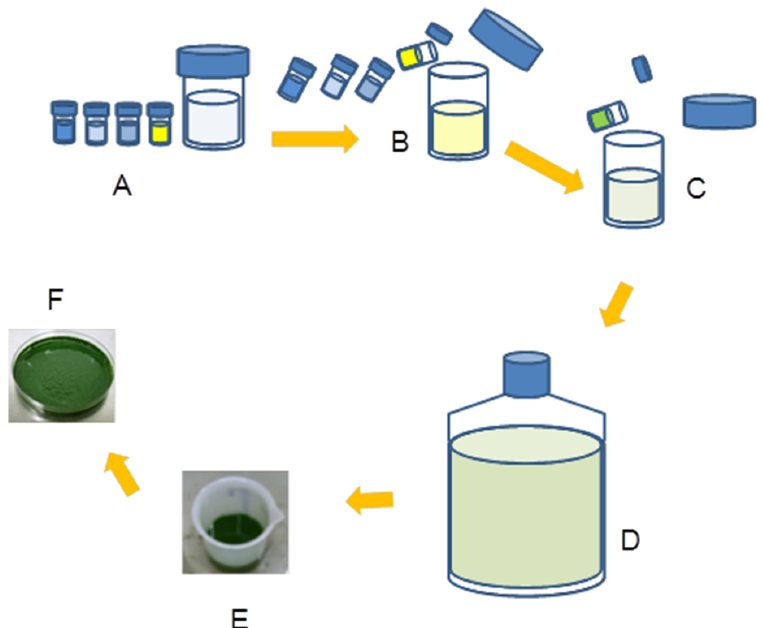
Figure 1. Cultivation of Egyptian A. platensis strain in the laboratory under static conditions. ( A ) Preparation of membrane filter 1.5 × medium components from parts A–C and the autoclaved part D; ( B ) mixing of the medium components under aseptic conditions; ( C ) adding the seed culture of A. platensis and the medium components to a sterile container; ( D , E ) static cultivation and collection of A. platensis ; ( F ) air drying of the harvested cells.